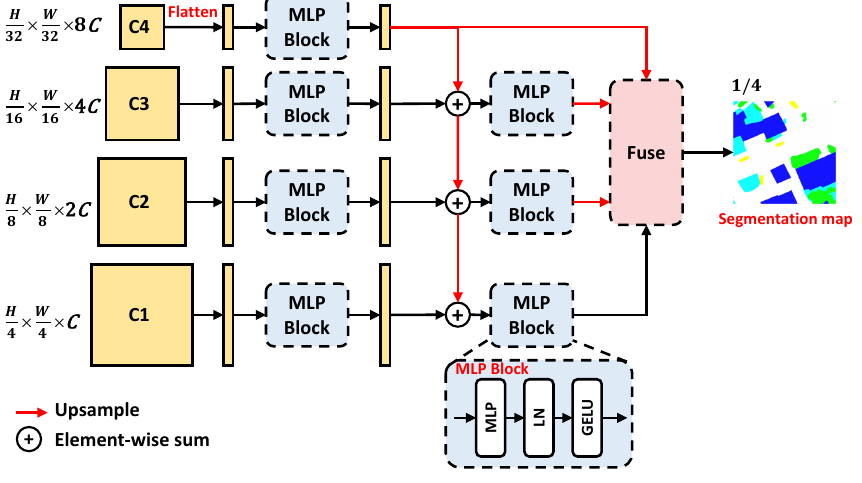
Figure 6. The architecture of